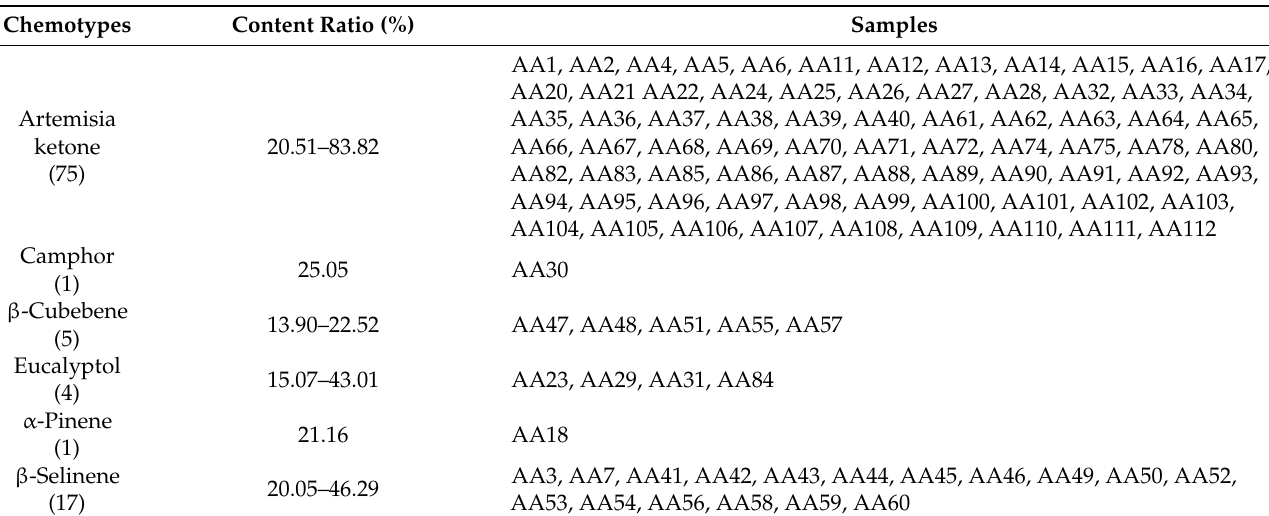
Table 2. The chemotype classification of Korean A. annua individuals based on the major component of essential